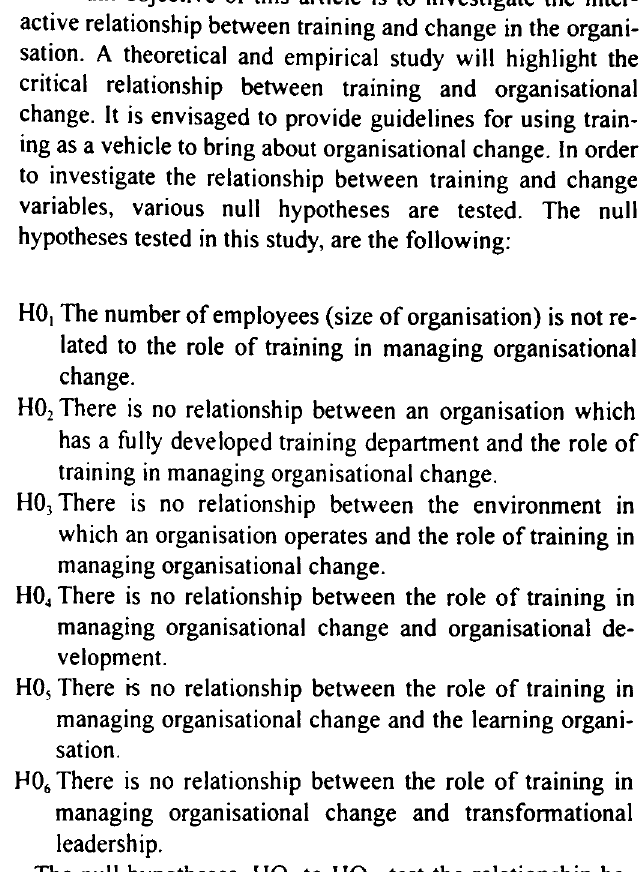
Figure 2 Role of training in managing strategic change (Source: adapted from Thompson & Mabey. 1994: